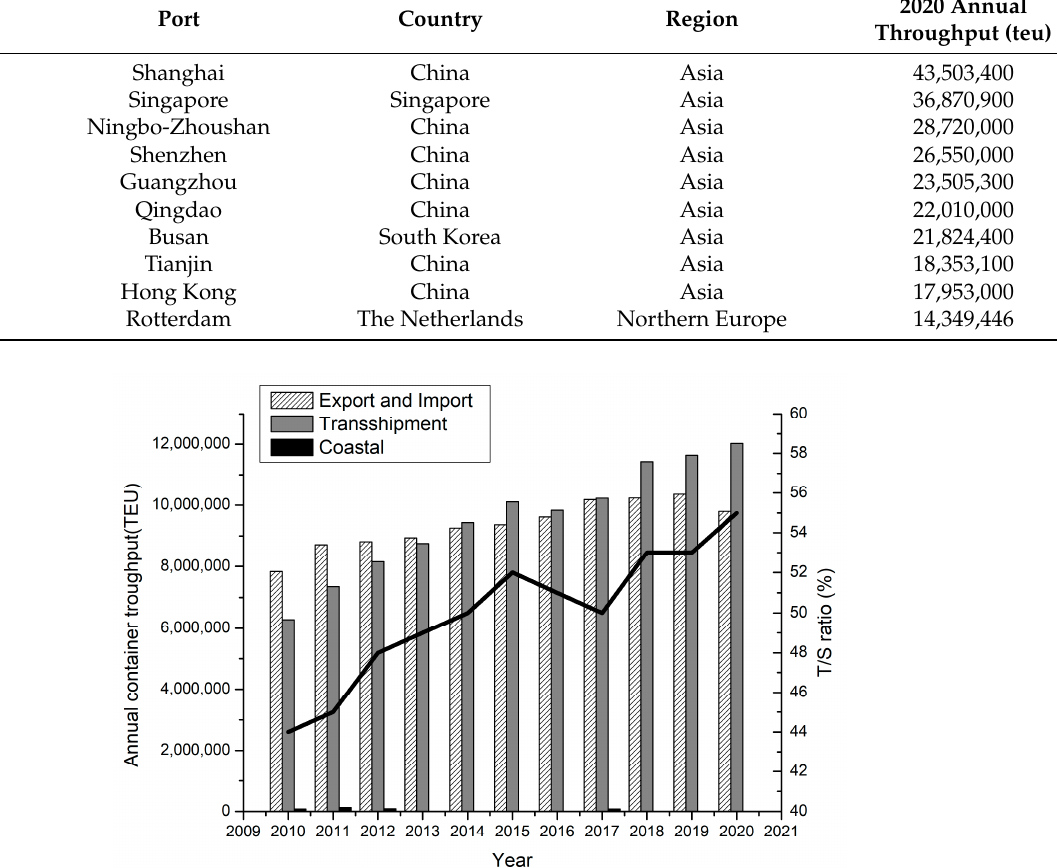
Figure 1. Container throughput and transshipment ratio in the Port of Busan (adapted from https://www.busanpa.com/kor/Contents.do?mCode=MN1004, accessed on 15 March 2022) [45].